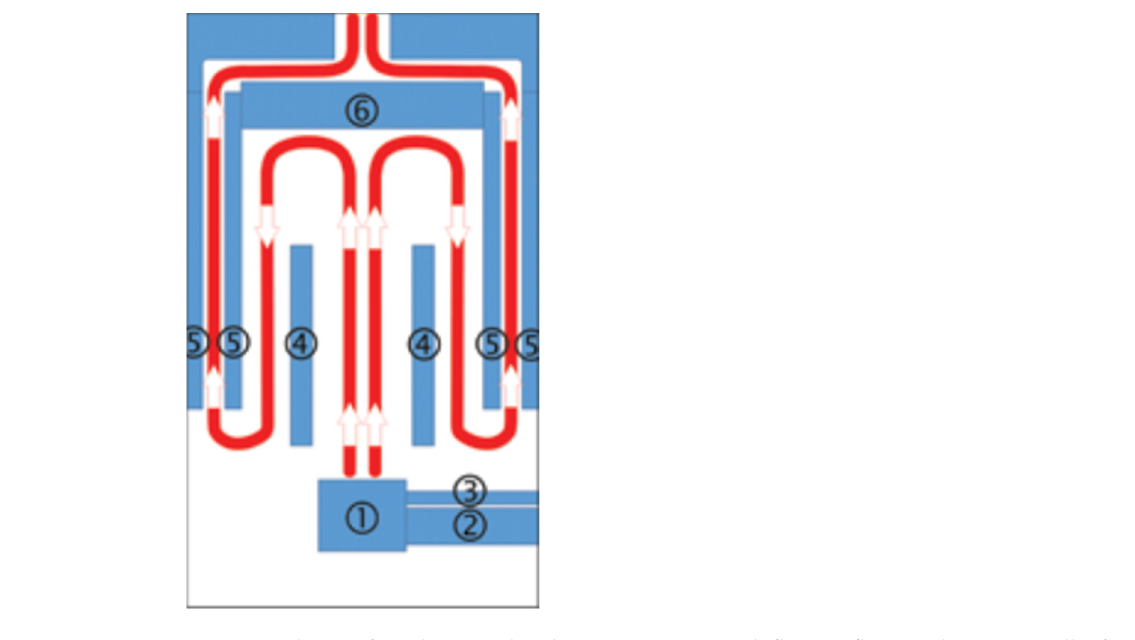
Figure 1. Scheme of combustion chamber construction, with flue gas flow—1: burner, 2: pellet feeder, 3: aeration pipe, 4: partition, 5: water jacket, 6: exhaust deflector. Table 1. Mass fraction of individual active substances in the produced catalytic